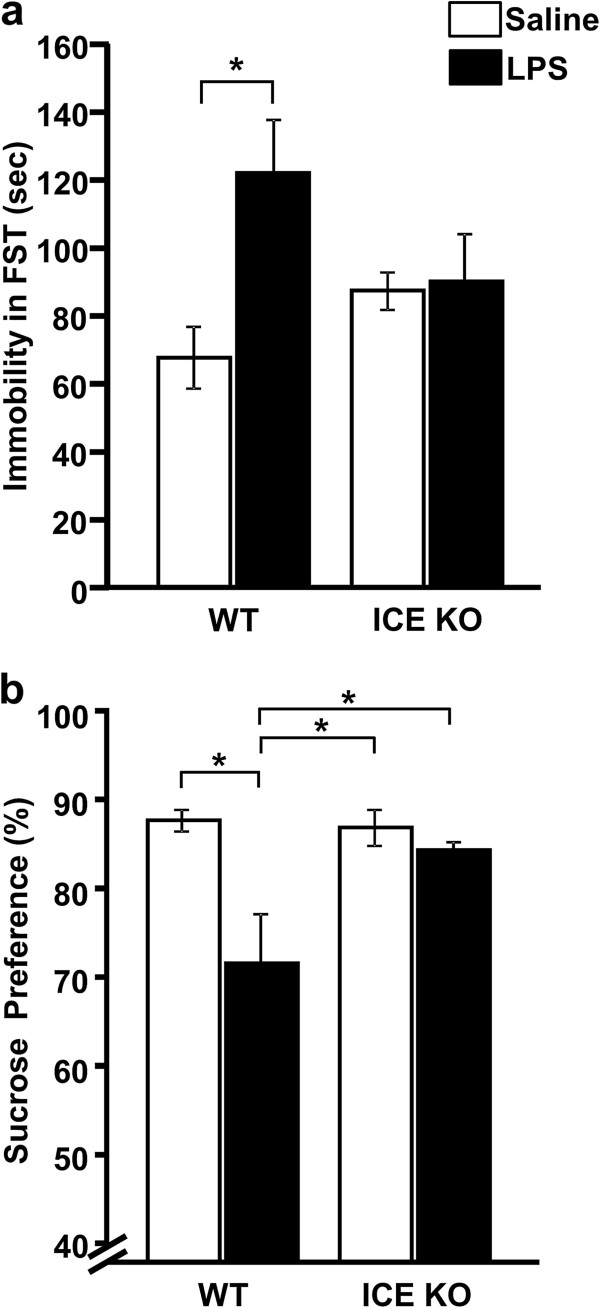
ICE KO mice were protected from depression-like behaviors following ICV administration of LPS compared to WT mice. (a) Time of immobility in the FST was determined 24 h after treatment. WT mice given LPS had greater time spent immobile compared to control WT mice, while immobility time in LPS-treated ICE KO mice was not different from control mice. (b) WT, but not ICE KO, mice displayed decreased preference for sucrose during the 24 to 48 h period following LPS injection. Data represent averages ± SEM. n = 9 to 12 mice per group, *P <0.05 comparing bracketed treatment groups.